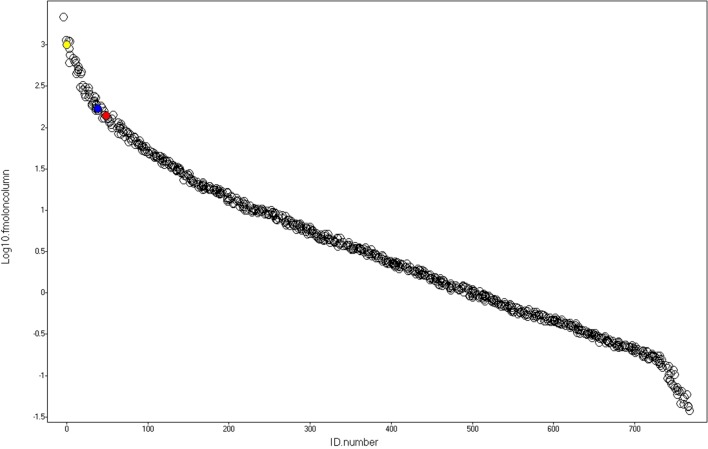
Dynamic range. After identification and absolute quantitation of the proteins using yeast alcohol dehydrogenase (red) as internal standard, alpha-1-antichymotrypsin (AACT_HUMAN) and alpha-1-antitrypsin (A1AT_HUMAN), represented by the blue and yellow spheres, respectively, were selected as housekeeping proteins used to normalize the data and perform label-free relative quantification of proteins present in the Unbound-PI and Bound-PII fractions, respectively.